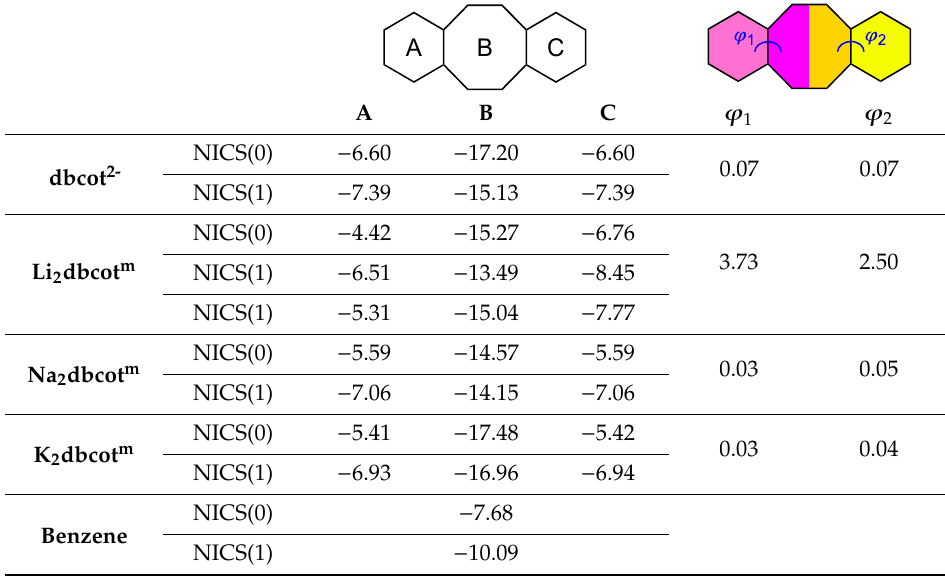
Abbreviations: ϕ 1 and ϕ 2 : dihedral angles of the optimized structures ( ◦ ).